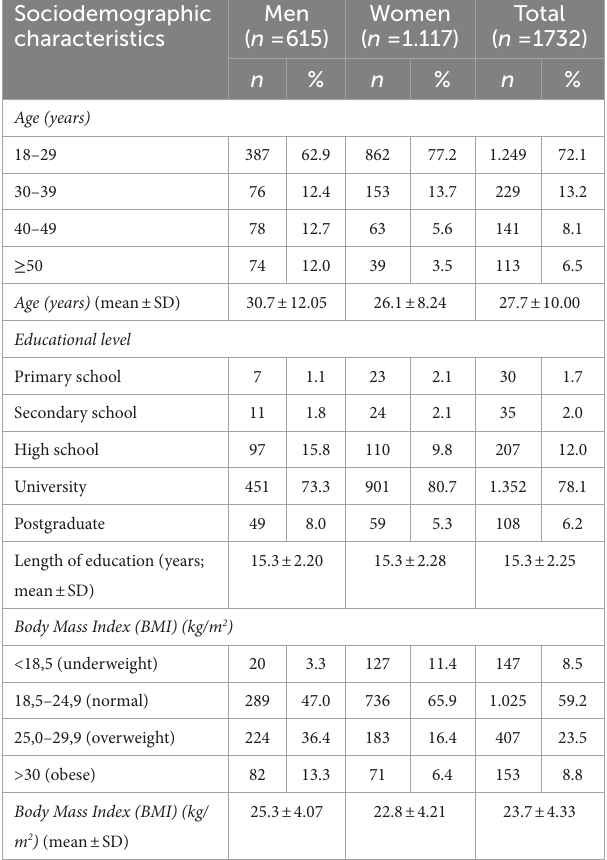
TABLE 1 Sociodemographic characteristics of the